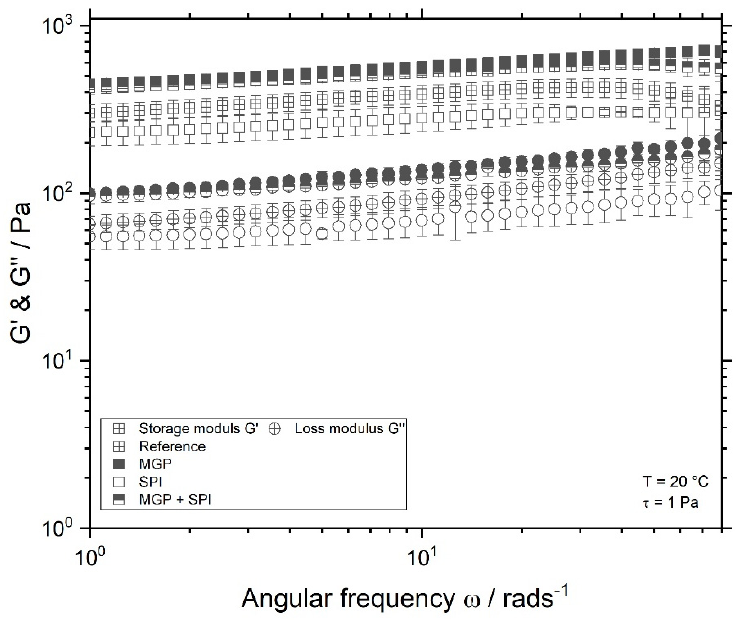
Figure 2. Amplitude test of fermented soy protein isolate (SPI) gels, measured at 20 °C, and an angular frequency of 1 rads − 1 . Reference sample, without oil and SPI emulsion gels (droplets stabilised with microgel particles (MGP) , with SPI , or both MGP + SPI ). Figure 3. Frequency test of fermented soy protein isolate (SPI) gels, measured at 20 °C, and an amplitude stress strain of 1 Pa. Reference sample, without oil and SPI-emulsion gels (droplets stabilised with microgel particles (MGP) , with SPI , or both MGP + SPI ).